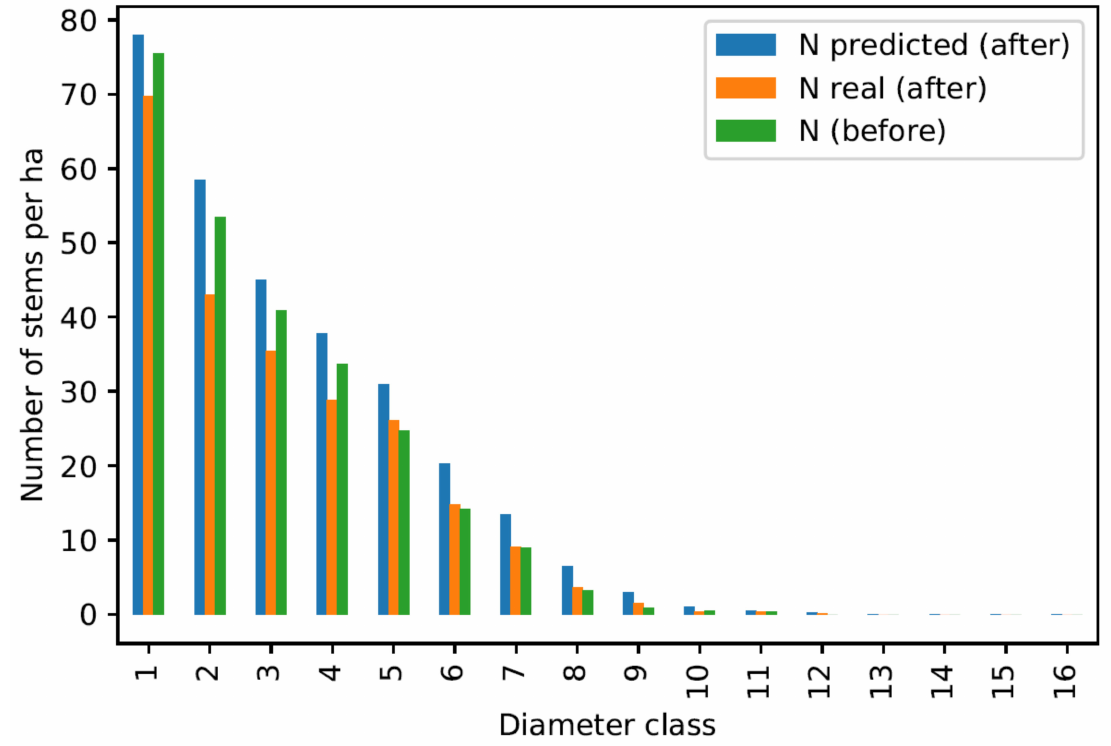
Figure 11. Overall prediction quality control for the division 1878 inventoried in the year